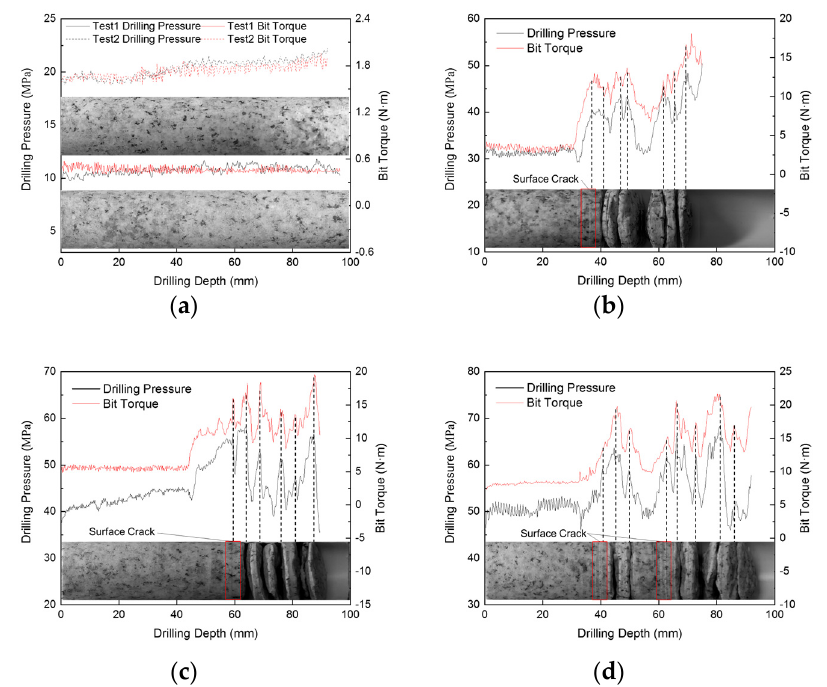
Figure 10. Drilling pressure and bit torque along with the core. ( a ) Test 1, test 2; ( b ) Test 3; ( c ) Test 4; ( d ) Test 5.